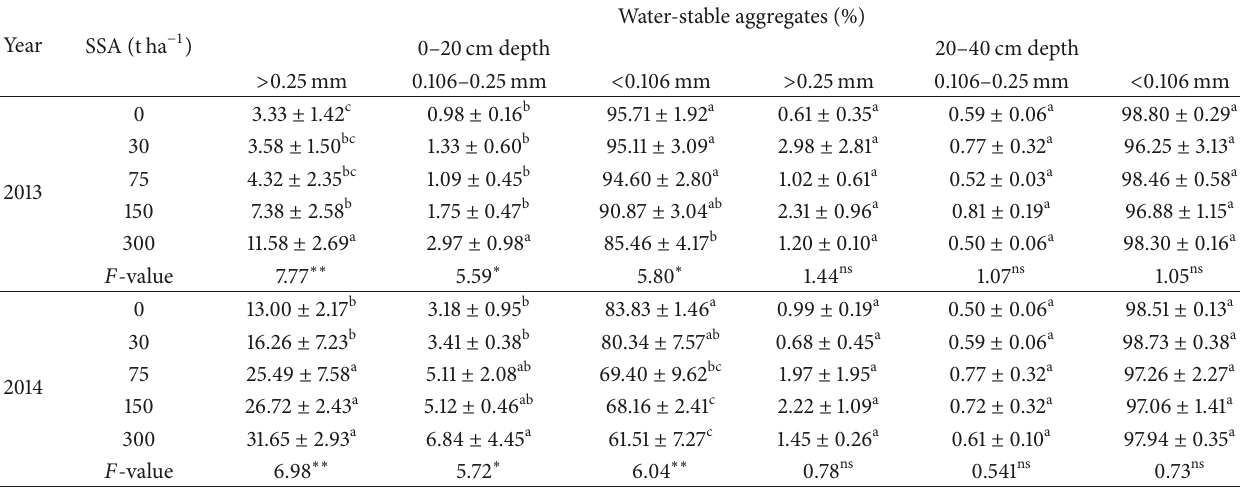
Values are mean ± SD of three replicates. Different letters in each column indicate significant difference at 𝑝 < 0.05 by LSD’s multiple range test. Values of 𝐹 are the 𝐹 test in ANOVA; ∗ 𝑝 < 0.05 ; ∗∗ 𝑝 < 0.01 ; ns 𝑝 > 0.05 .